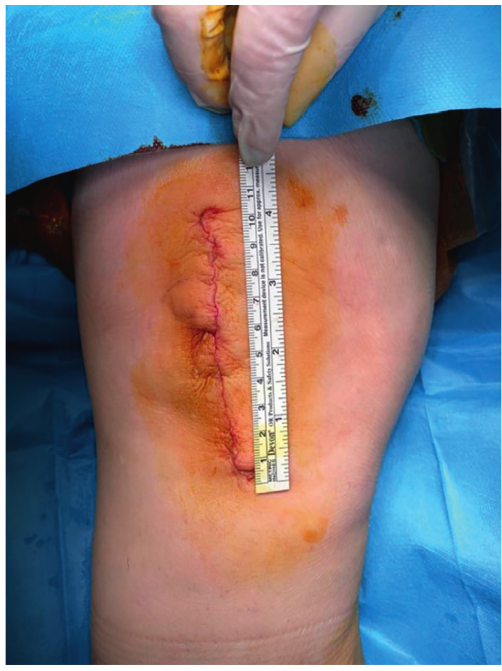
Figure 1: The measurement of incision length at extension of the